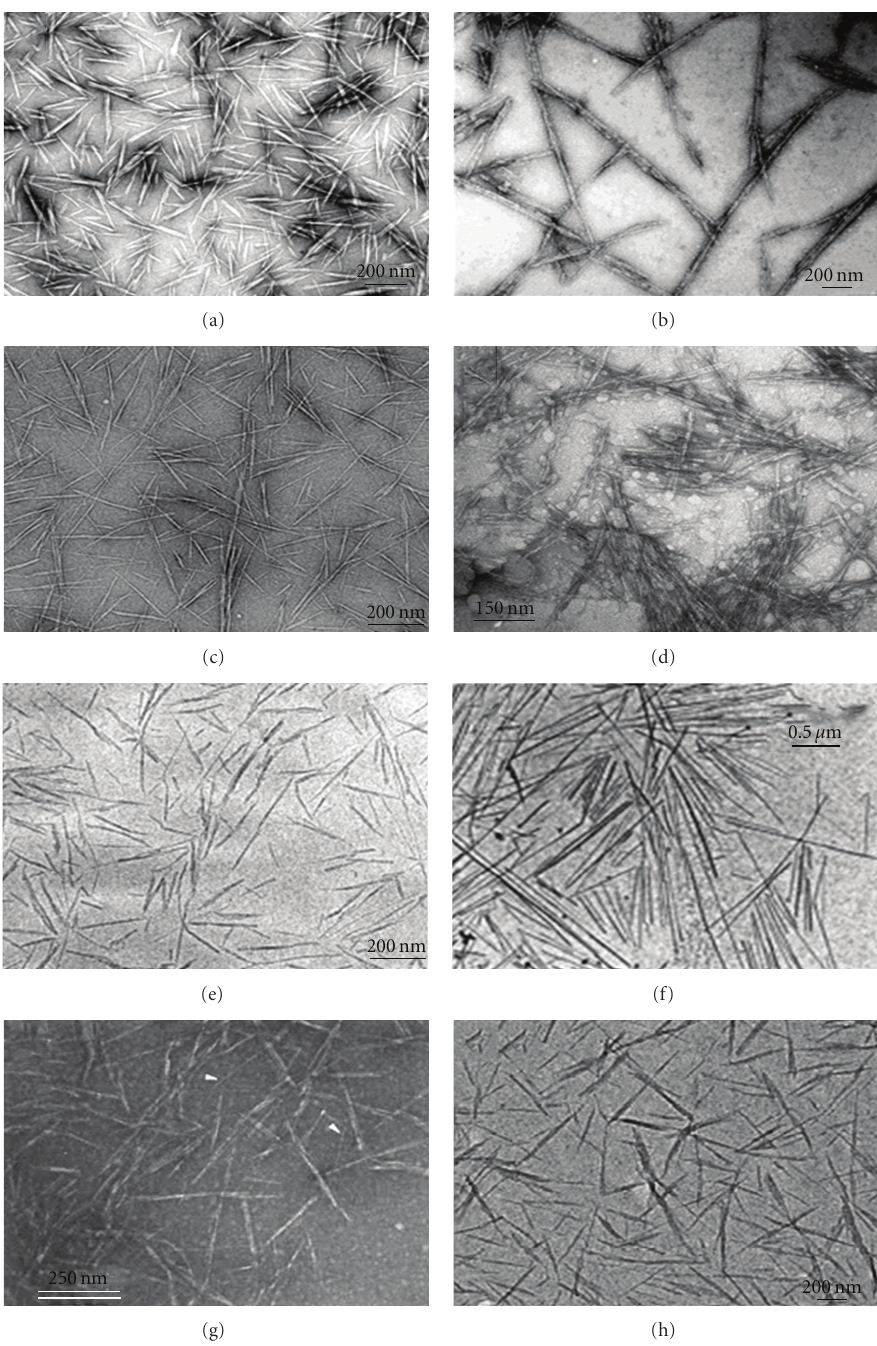
Figure 12: Transmission electron micrographs from dilute suspension of cellulose nanocrystals from: (a) ramie [97], (b) bacterial [98], (c) sisal [99], (d) microcrystalline cellulose [100], (e) sugar beet pulp [101], (f) tunicin [102], (g) wheat straw [103], and (h) cotton [104].